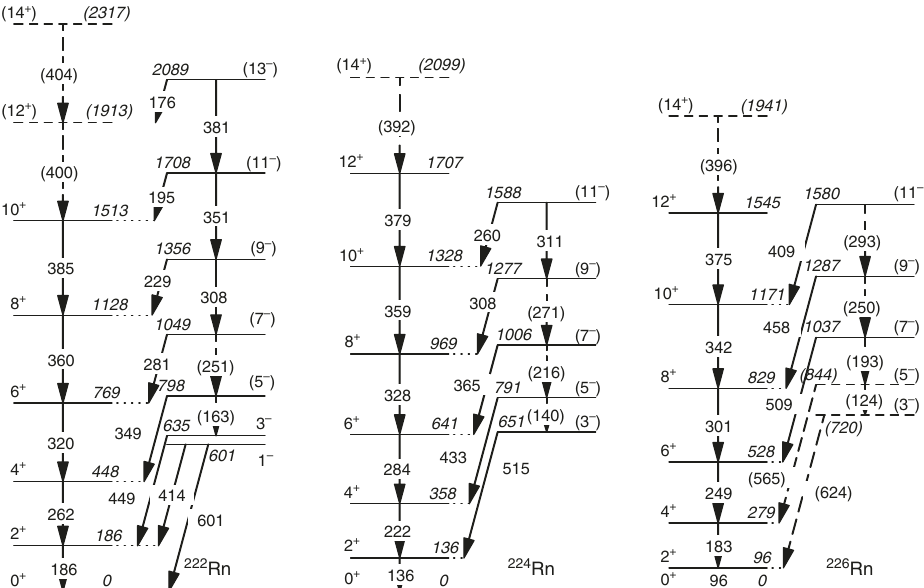
Fig. 3 Level schemes. These partial level-schemes for 222,224,226 Rn show the excited states of interest. Arrows indicate γ -ray transitions. All energies are in keV. Firm assignments of transitions and energy levels in the scheme are from previous work or have been made using γ – γ -coincidence relations; tentatively assigned transitions such as those from the 3 − and 5 − states in 226 Rn are shown as dashed lines. The assignment of spins and parities in brackets are tentative.